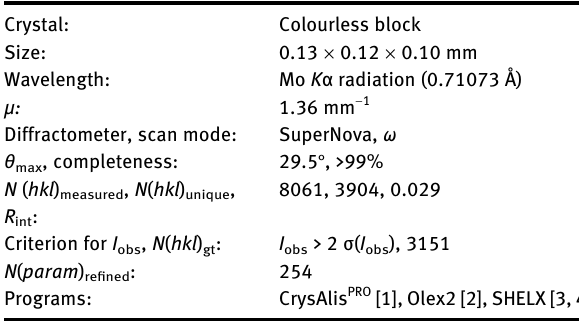
figure. Table 1 contains crystallographic data and Table 2 contains the list of the atoms including atomic co- ordinates and displacement parameters.